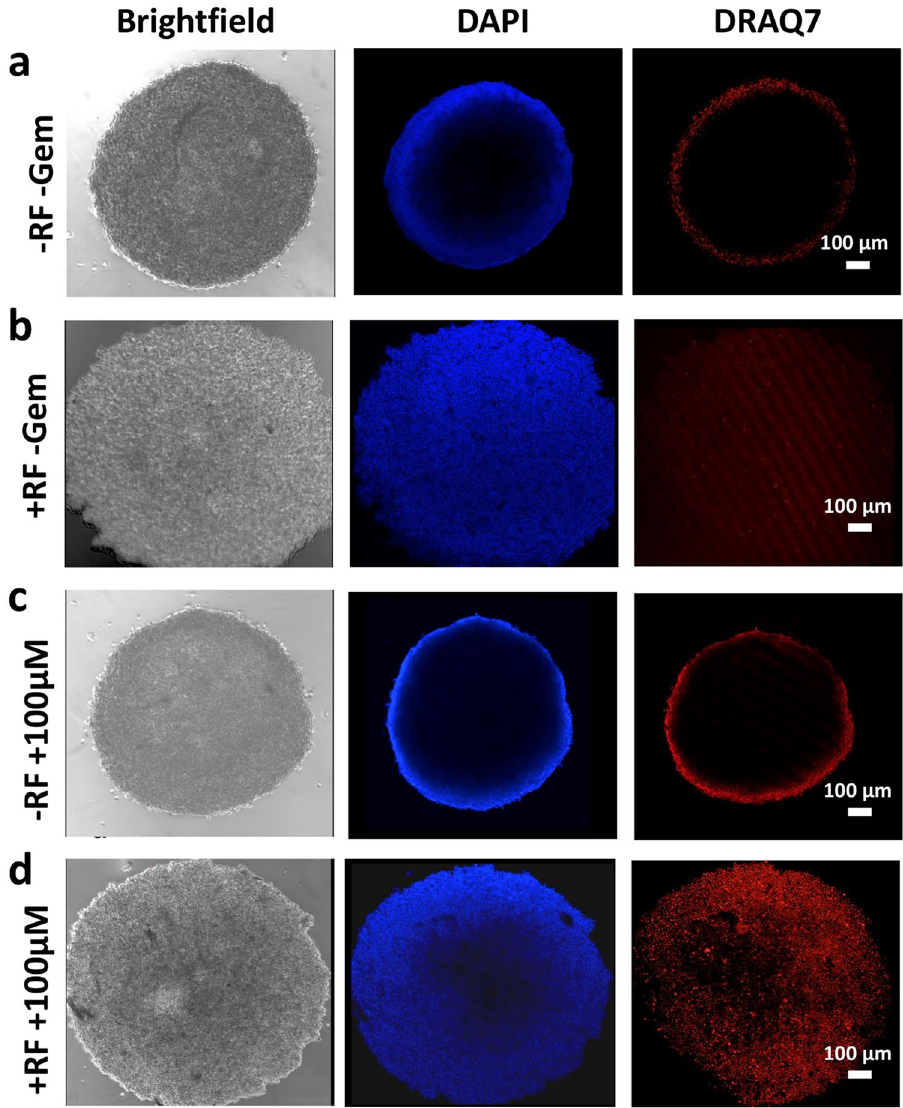
100 μ M Gem only for 24 h; ( d ) Spheroid pretreated with RF and exposed to 100 μ M Gem for 24